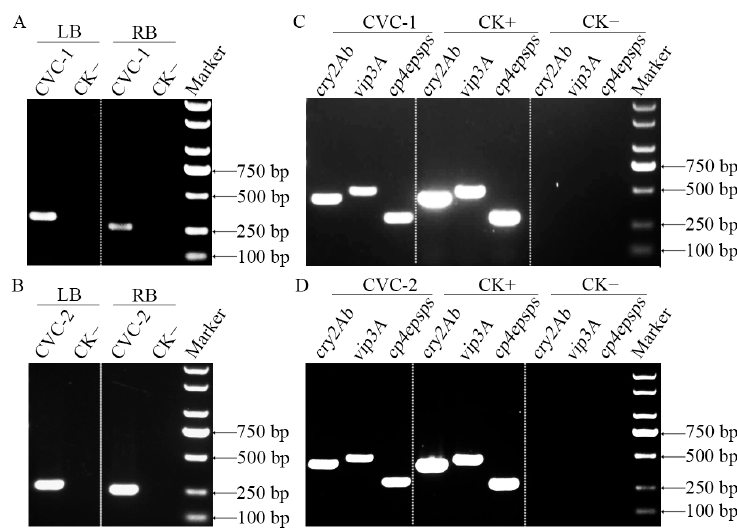
Figure 3. PCR specific identification of foreign T-DNA and target genes. The specific PCR identification of the flanking sequences of the transgenic maize CVC-1 ( A ) and CVC-2 ( B ); The PCR detection of cry2Ab , vip3A , and cp4epsps target genes in CVC-1 ( C ) and CVC-2 ( D ). LB: LB terminal flanking sequence; RB: RB terminal flanking sequence; CVC-1 and CVC-2: Transgenic maize events; CK+: Positive control of pL7-2 plasmid; CK − : Negative control of non-transgenic maize Zheng 58.